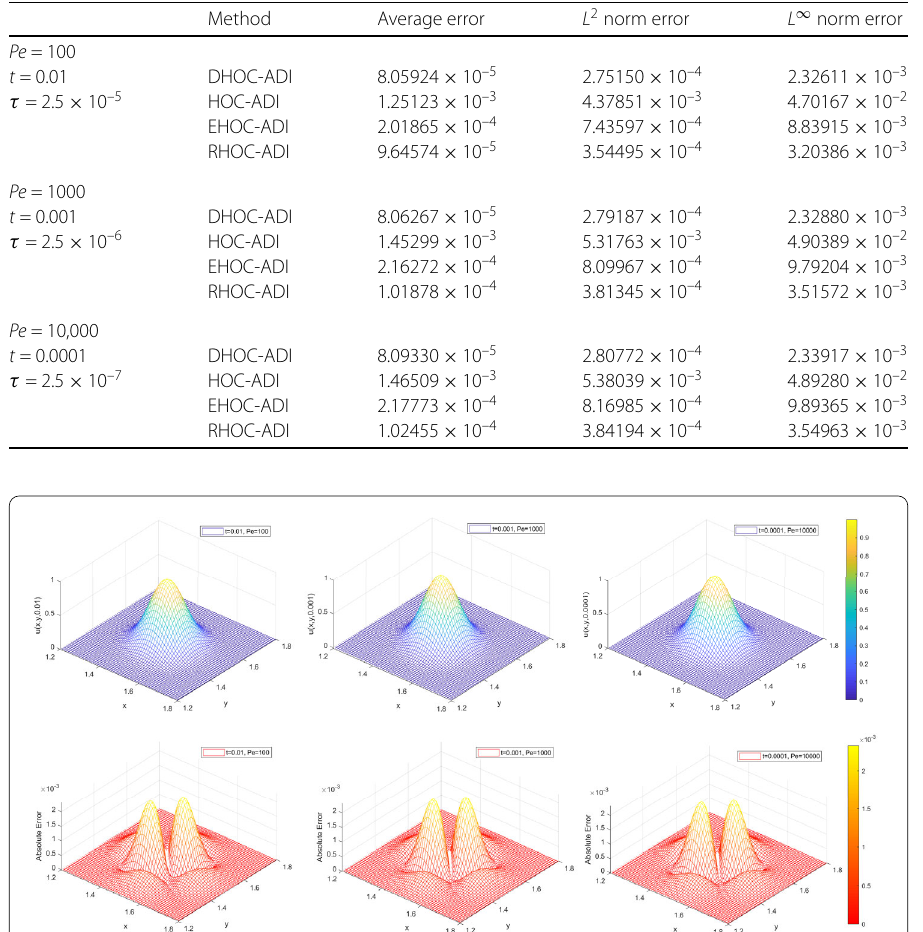
Figure 8 Numerical solutions (top) and absolute errors (bottom) in sub-region 1.2 ≤ x , y ≤ 1.8 with different